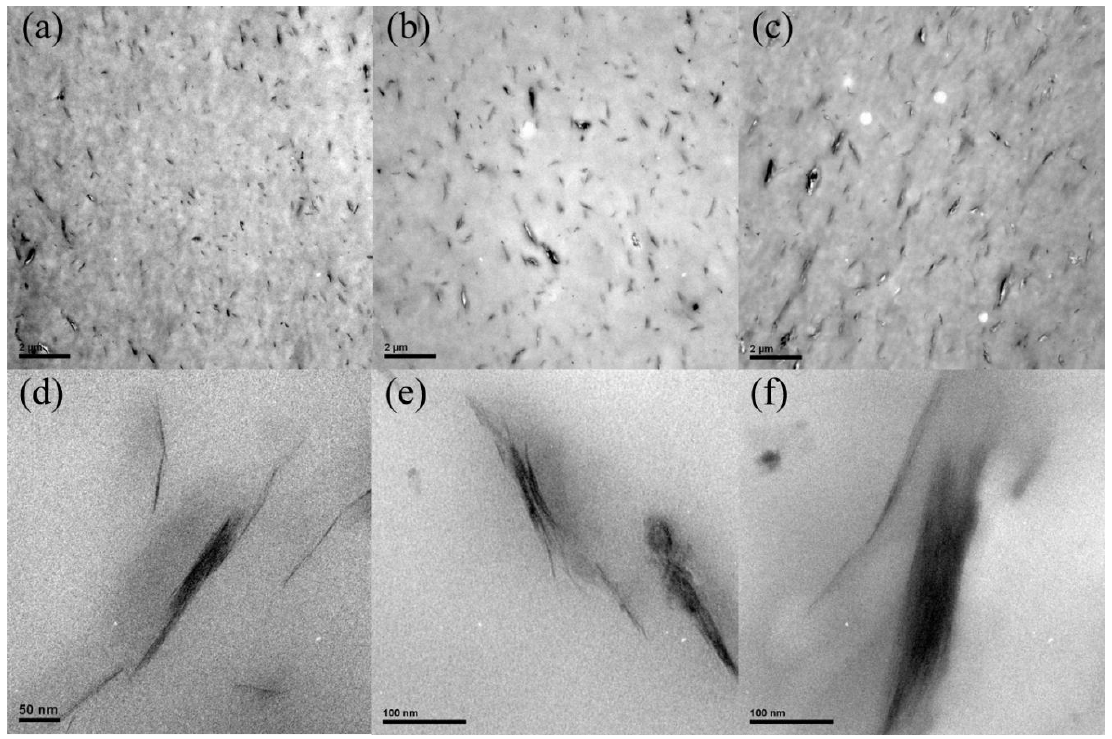
Figure 2. TEM images of PPSBM x composites: ( a , d ) 1 wt. %, ( b , e ) 3 wt. %, and ( c , f ) 5 wt. %.